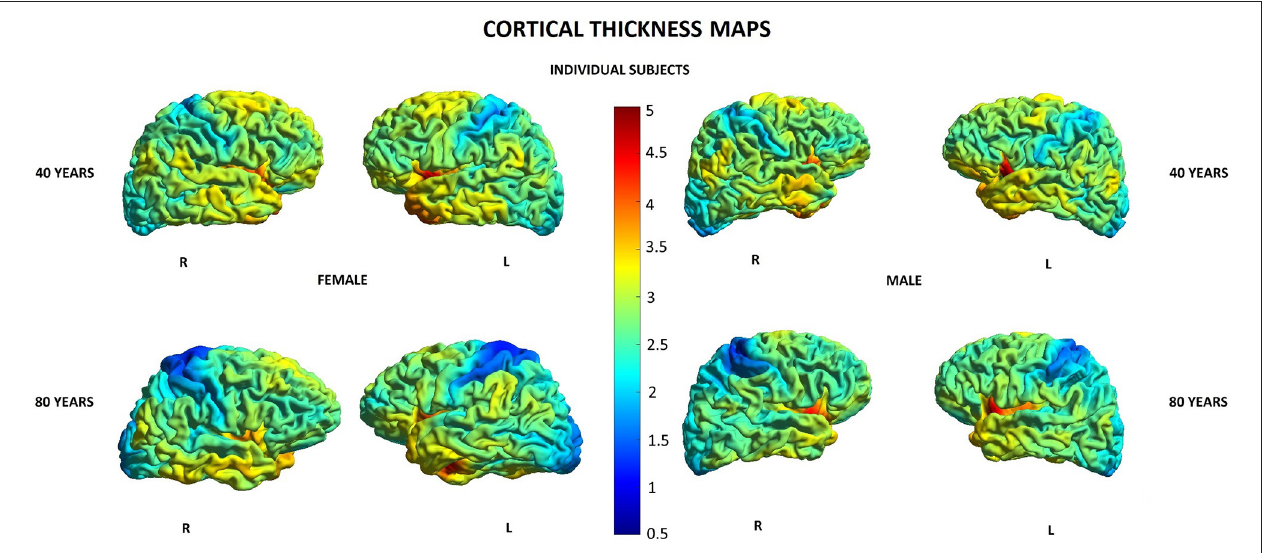
FIGURE 3 | Cortical maps of age-related distribution of cortical thickness in 40- and 80-year-old female and male individual subjects. Lateral views of right (R) and left (L) hemispheres.